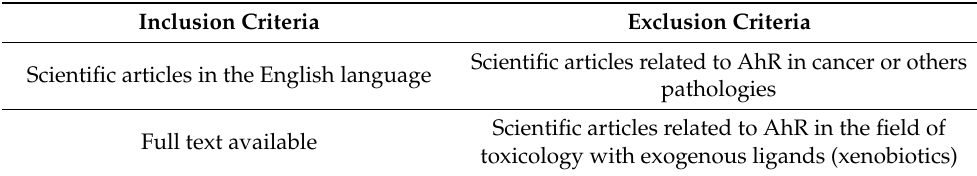
Table 5. Inclusion and exclusion criteria.